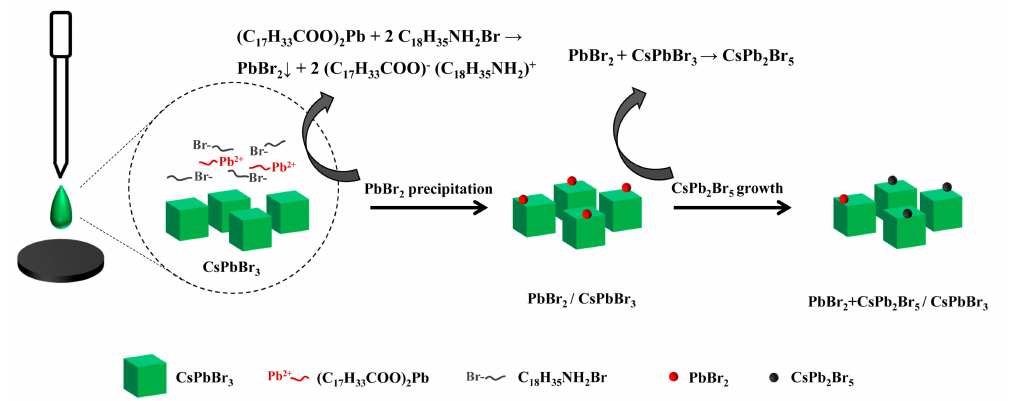
Figure 6. Schematic of the formation mechanism of the PbBr 2 NPs and the CsPb 2 Br 5 NPs on CsPbBr 3